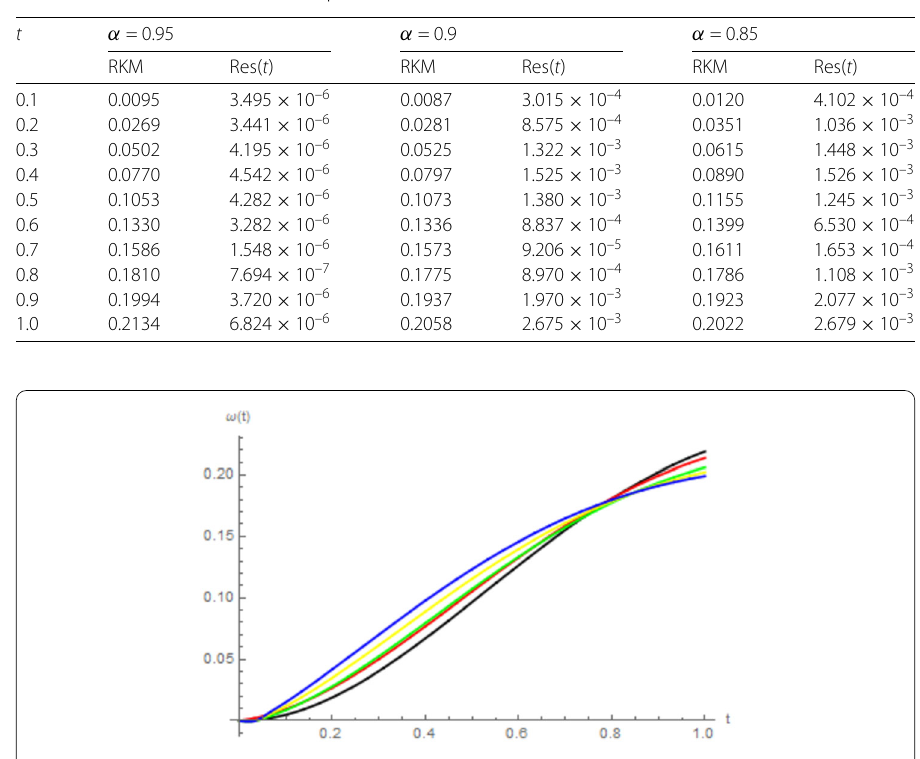
Table 1 Numerical results of Example 5.1 when n = 30